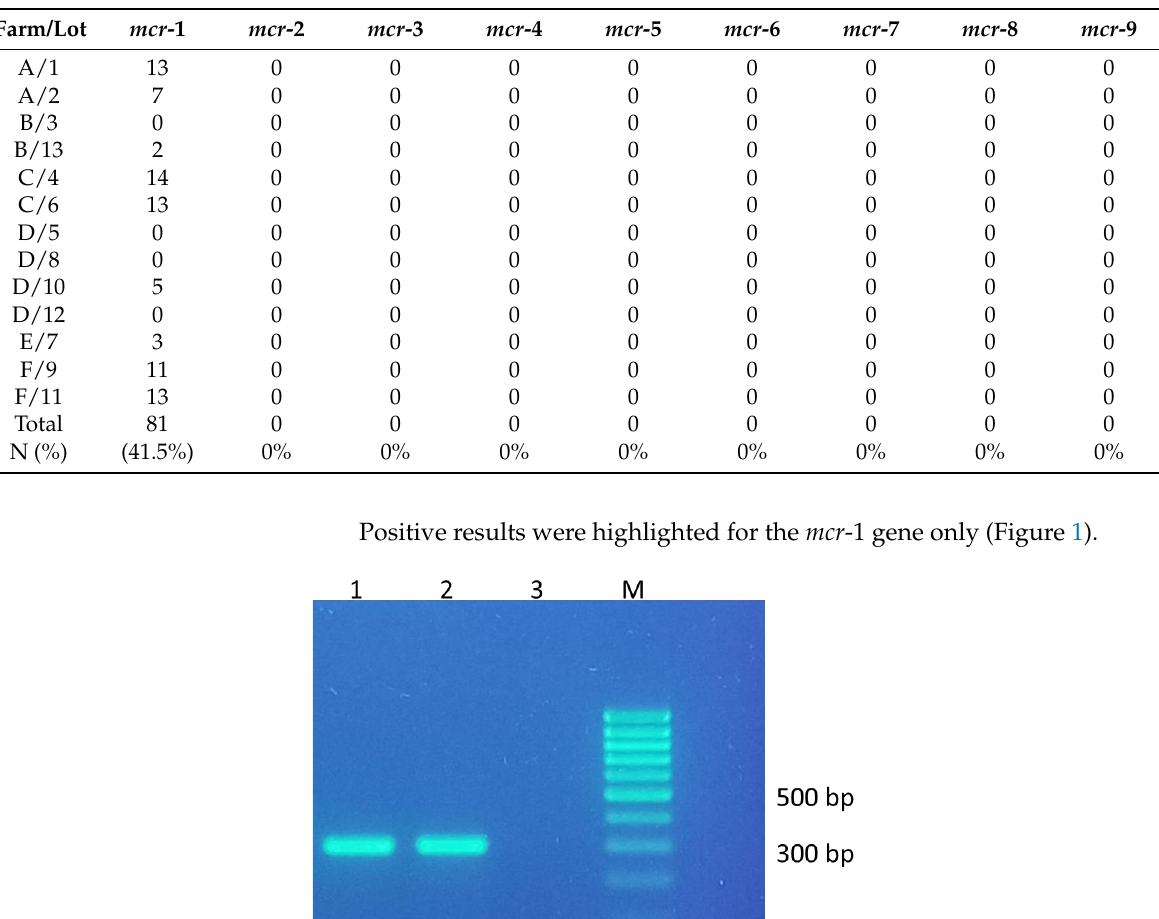
Table 2. Number of cloacal swabs PCR positive for colistin resistance genes mcr -1 to mcr -10. (Each lot consisted of 15 animals).